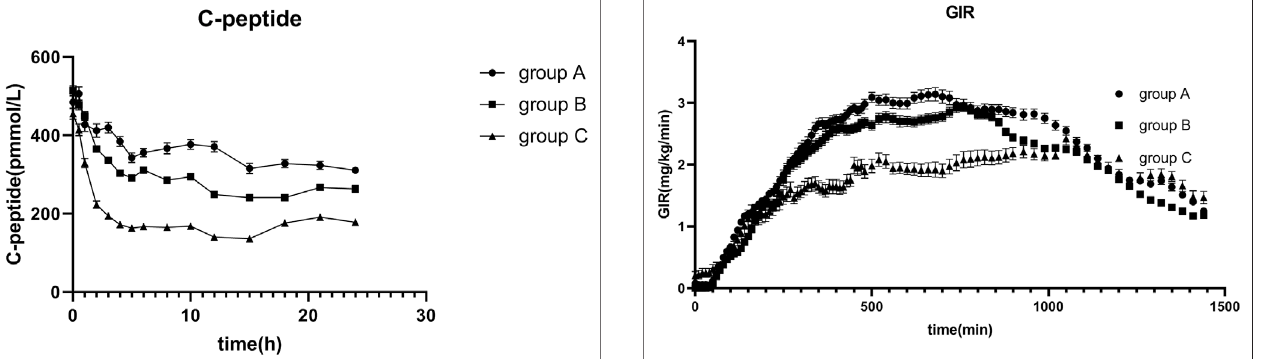
FIGURE 3 | Glucose infusion rate (GIR) versus time pro fi les after 0.4 IU/kg doses of glargine insulin in healthy volunteers. The error bars represent the 95% con fi dence intervals. GIRin group C waslower than that in the others, but there were no statistical differences among groups.